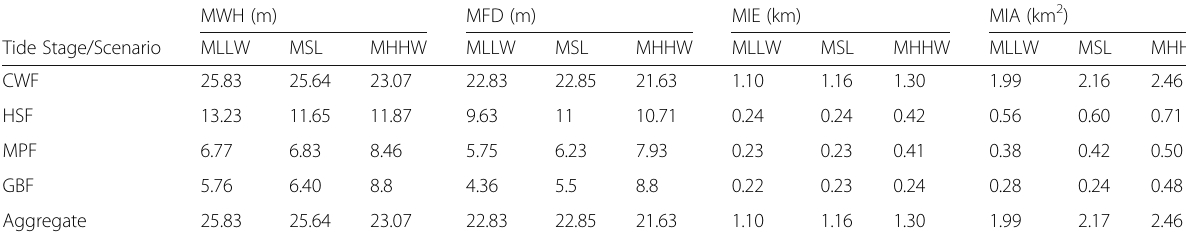
Table 3 Summary table of resulted MHW, MFD, MIE and MIA for each proposed source model of the 1st November 1755 Lisbon earthquake and the aggregate scenario considering the three tide stages